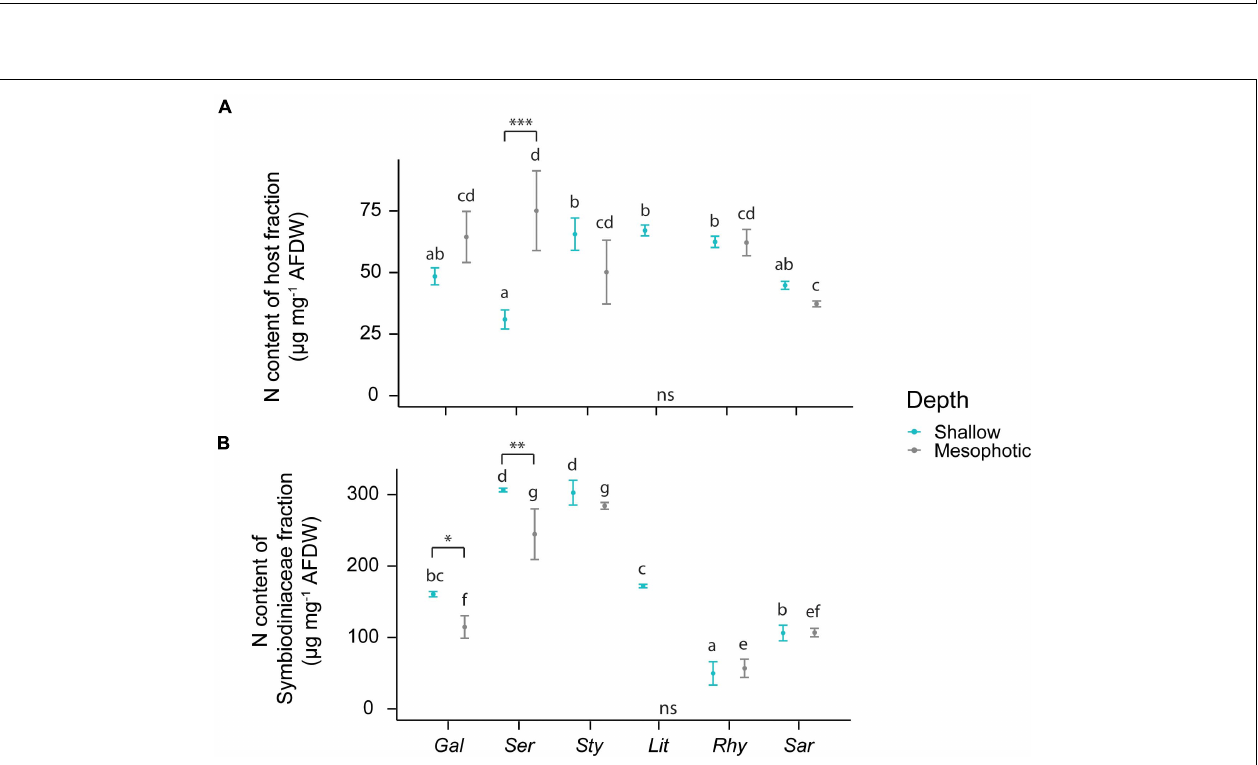
FIGURE 2 | Symbiodiniaceae density in the species investigated. The first three species [ Galaxea fascicularis (Gal), Seriatopora hystrix (Ser), Stylophora pistillata (Sty)] are hard corals and the last three [ Litophyton arboreum (Lit), Rhytisma fulvum fulvum (Rhy), Sarcophyton sp. (Sar)] are soft corals. Significant differences between depths are displayed with an asterisk ( ∗ for p < 0.05). Significant differences between species are distinguished with letters by depth. AFDW = ash-free dry weight. ns = not sampled.